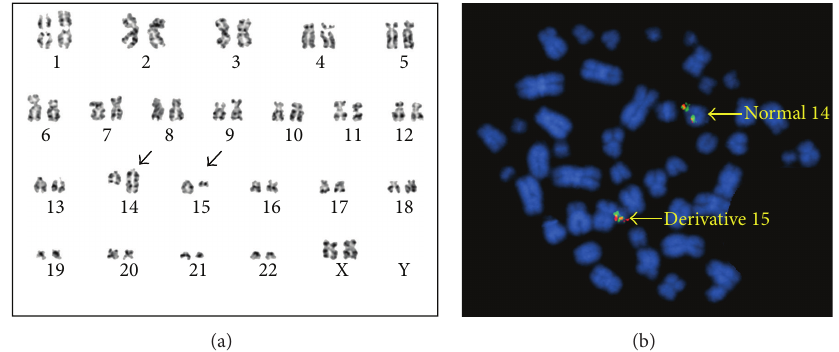
Figure 1: (a) G-banded chromosome analysis showed an apparently balanced translocation between chromosomes 14 and 15 at breakpoints of 14q32 and 15q13, respectively. (b) FISH analysis using IGHG1 break-apart probe revealed intact signals on a normal chromosome 14 and a derivative chromosome